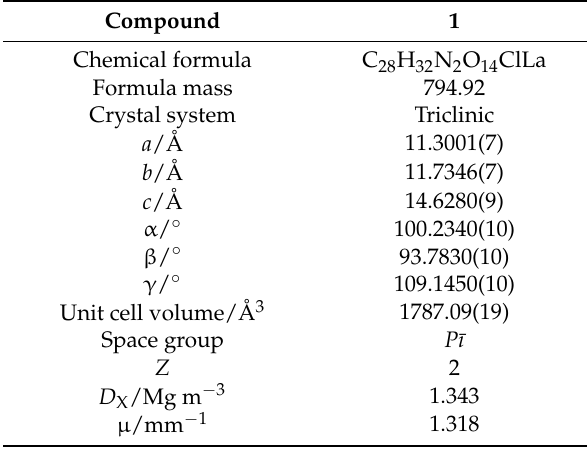
Table 1. Crystal data and structure refinement for 1